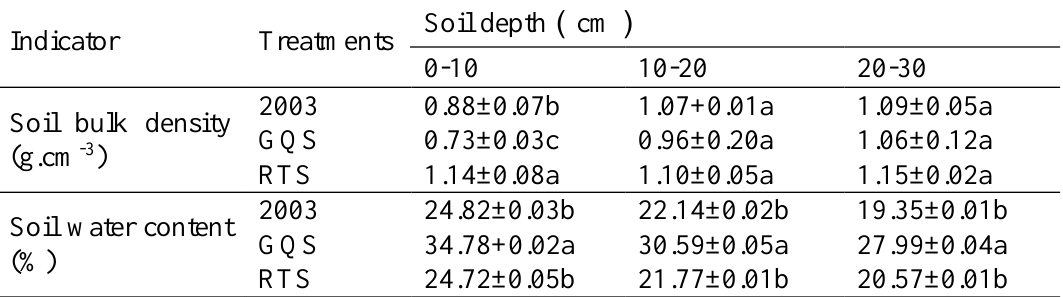
Table A1.1 . Soil bulk density and water content of summer pasture in at baseline in 2003, and under the community quota system (GQS) and rangeland transfer system (RTS) in 2014 (different letters significant at P<0.05 within columns) (n=9).